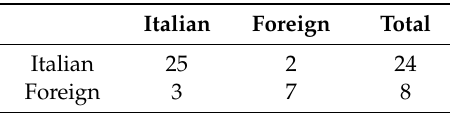
Table 3. Confusion matrix of the test set of the MLFN model used in predicting the classification of Italian vs. foreign EVOO. The correctly classified samples are reported on the main diagonal of the matrix.